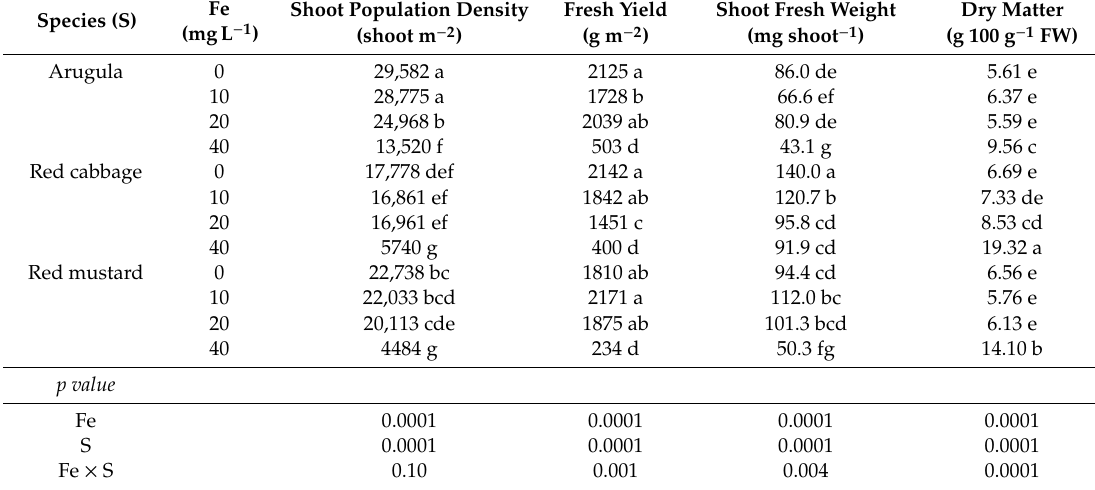
Table 3. Nutrient solution iron (Fe) level effects on shoot population density, fresh yield, mean